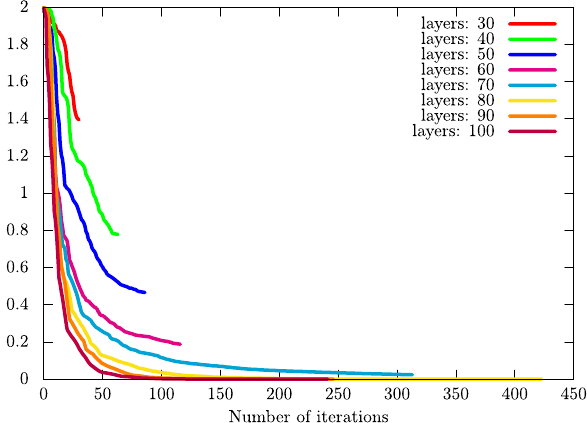
Figure 6. Values of the cost function J cost (θ , (cid:31) ; L , 2, ˆ U ) , Eq. (26) with p = 2 , for the cancer dataset (0 or 1). We set L = 30, 40, 50, 60, 70, 80, 90, 100